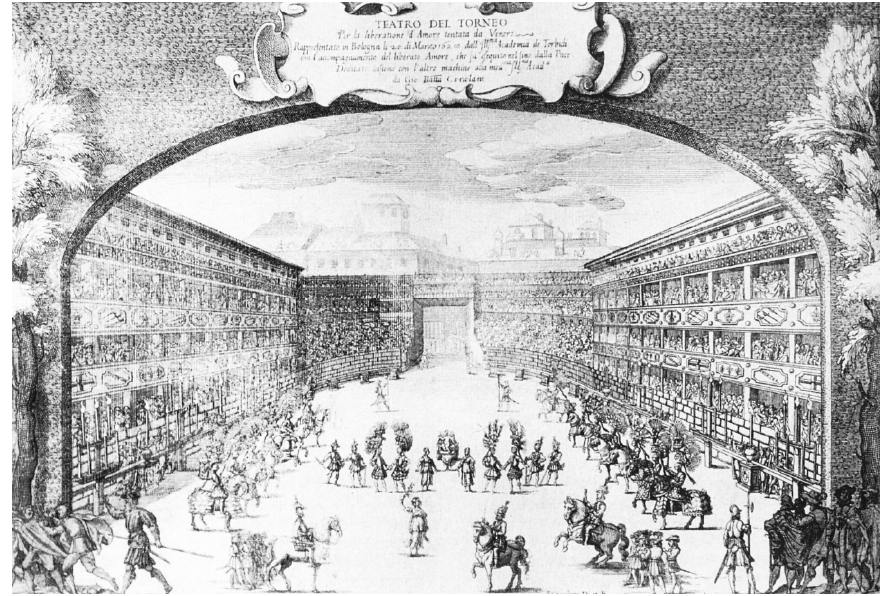
Figure 14. Table on the Triumph of Virtue Modena 1660 of Girolamo Grazian, in Fagiolo M. (Ed.) L’effimero Bolognese, Italia [21].